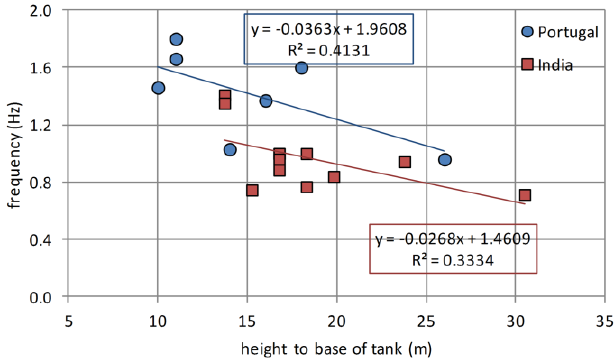
Fig. 5. Comparison between in-situ measurements in India and Portugal for typology 1 (frequency of 1st